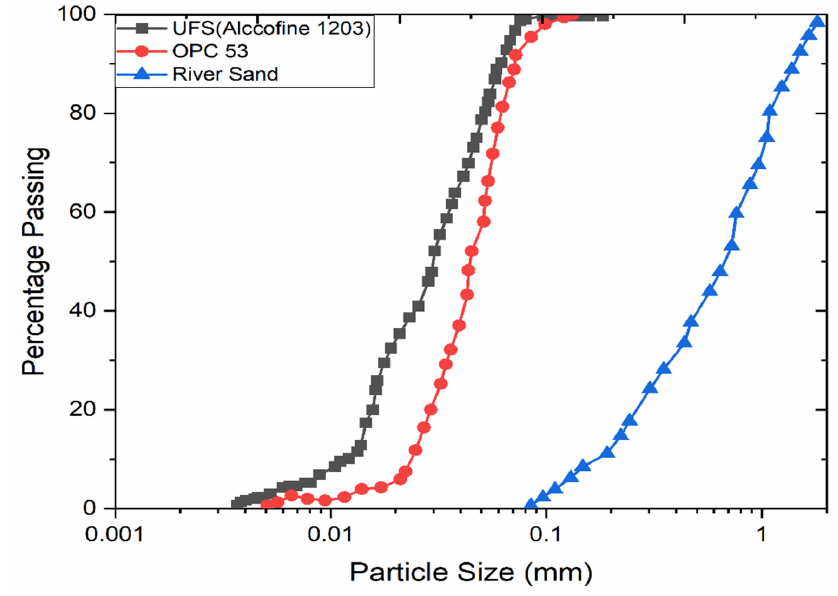
Figure 1. Particle Size Distribution .